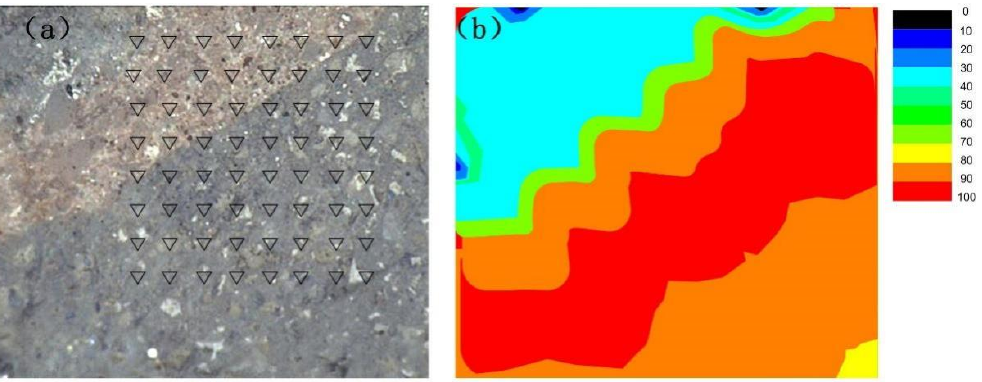
Figure 4. The change rule of elastic modulus of indentation points in specimen B1 after 28 days curing times ( a ) Indentation point distribution diagram, ( b ) Elastic modulus distribution nephogram.